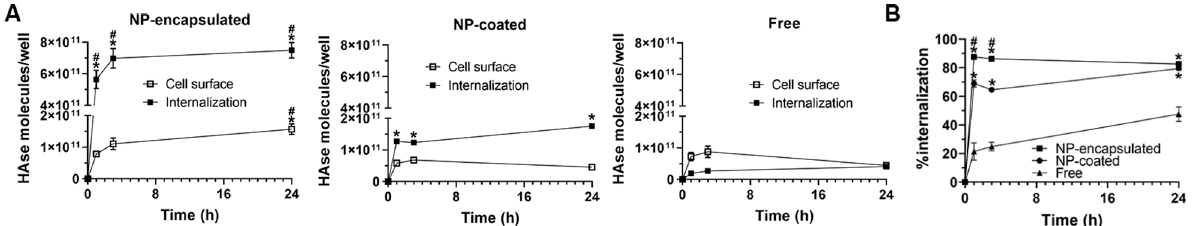
Figure 5. HAse delivery to cells by encapsulated vs. coated anti-ICAM PLGA NP formulations. TNF α -treated HUVECs were incubated with anti-ICAM PLGA NPs bearing 2.25 µ g/mL encapsulated vs. coated 125 I-HAse, compared to the same dose of free 125 I-HAse. ( A ) 125 I-HAse delivered to cells was quantified before and after removal of the cell-surface fraction by acid glycine solution to determine internalized 125 I-HAse. ( B ) Enzyme internalization expressed as percentage of the total (surface + internal) 125 I-HAse associated to cells. Data are the mean ± SEM ( n ≥ 4; non-visible error bars are hidden by the data symbol) and statistics were assessed by Student’s t -test ( p < 0.05). * Compares each NP formulation vs. free 125 I-HAse at respective times and locations; # Compares NP encapsulated vs. coated enzyme for respective times and locations.